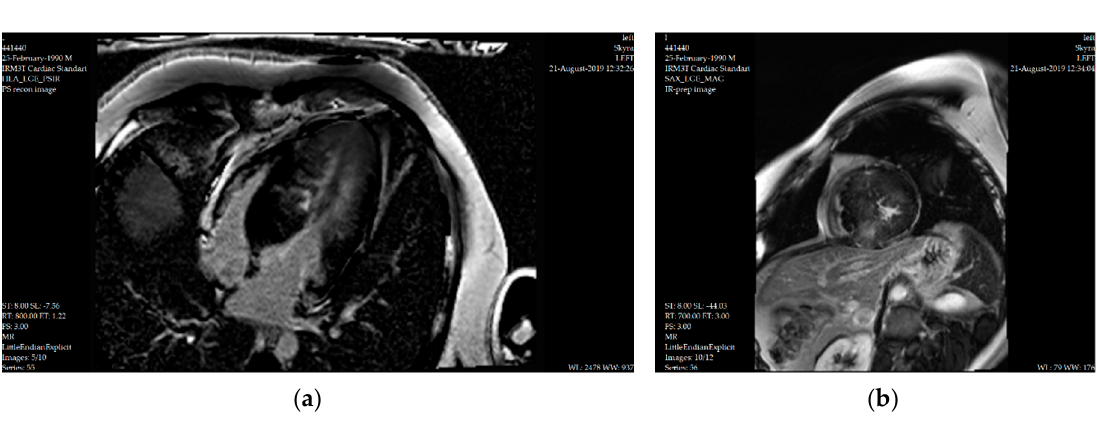
Figure 3. Late gadolinium enhancement images: ( a ) four-chamber view and ( b ) short-axis view, with diffuse nonischemic fibrotic lesions in the left ventricular myocardium and intramural nodular fibrotic lesions in the interventricular septum, in the same 20-year-old patient.